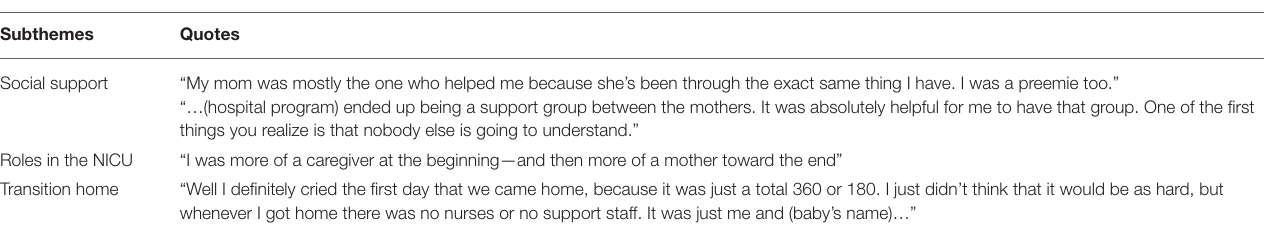
TABLE 6 | Theme 4: Maternal Experience in the NICU.